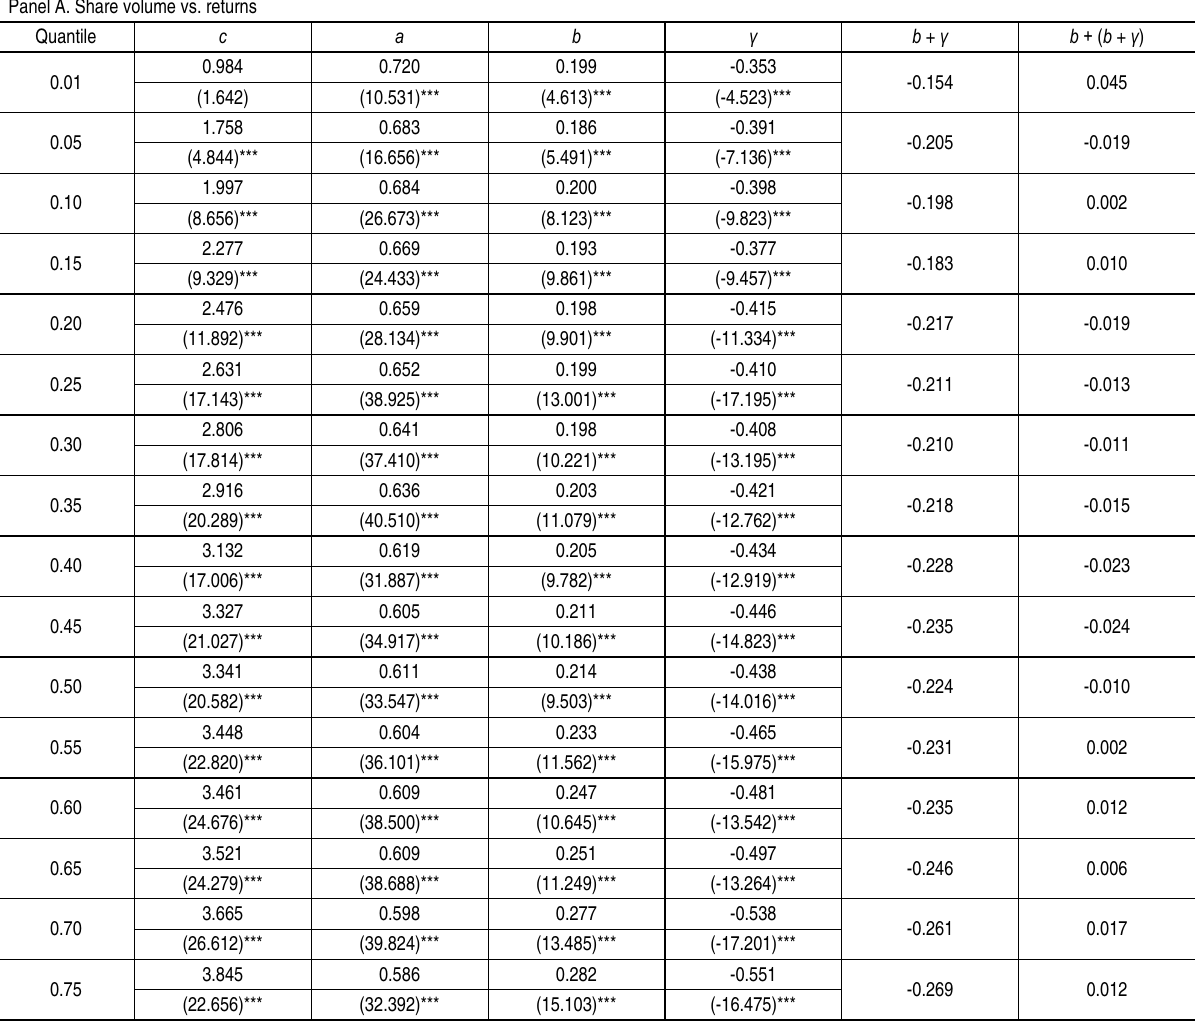
Table 5. Quantile regression estimates of volume-signed return correlation for Taiwan 50 ETF in the full-sample